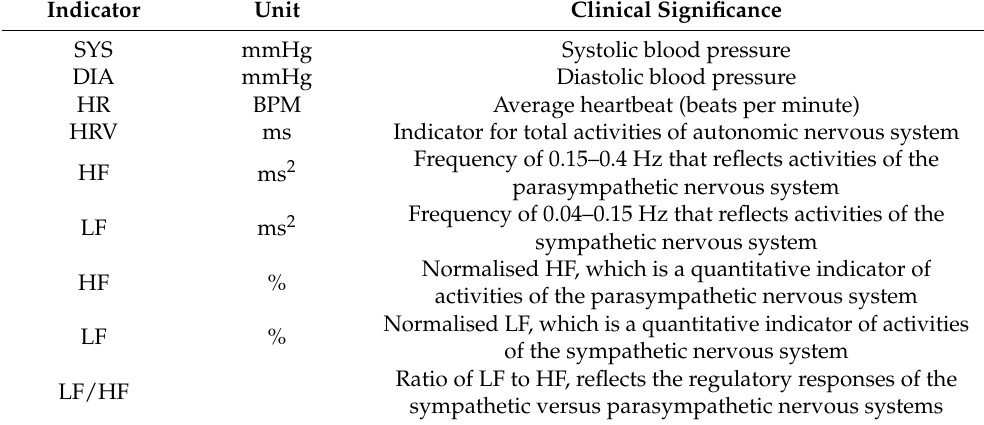
Table 1. Physiological indicators and their clinical significance.